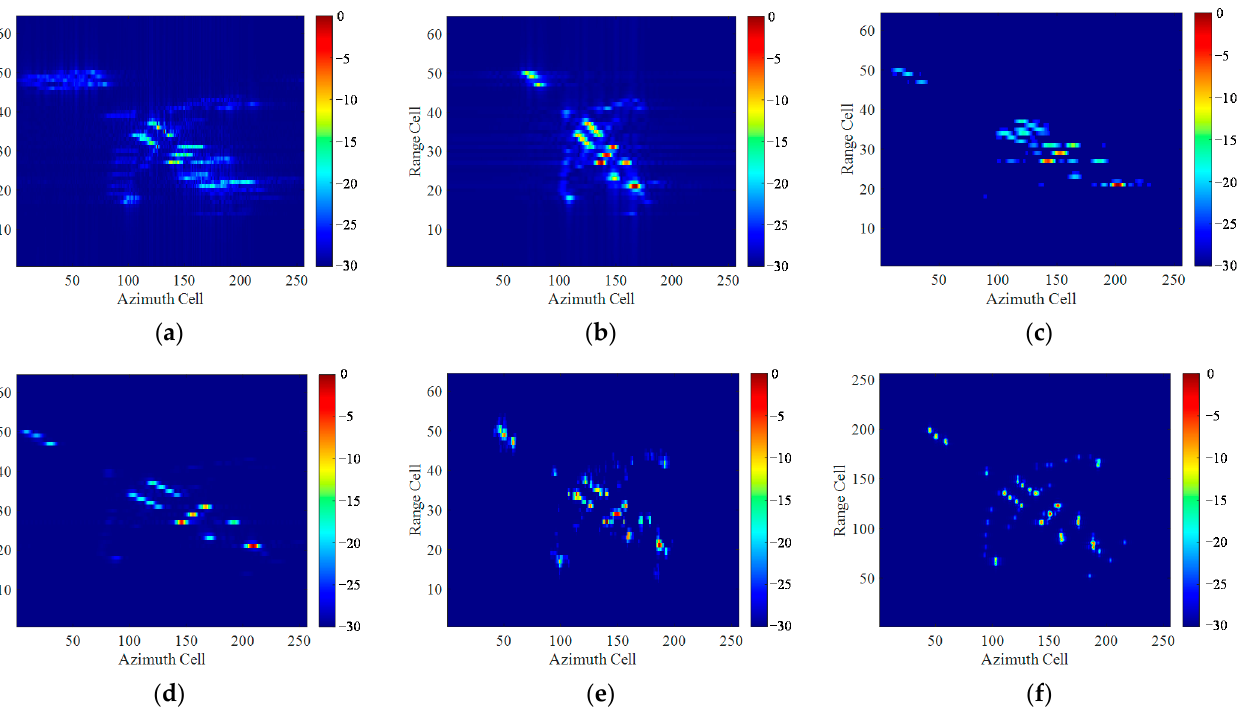
Figure 12. Imaging results of Boeing-727 data under full aperture without noise by different methods: ( a ) RD algorithm; ( b ) STFT algorithm; ( c ) WVD algorithm; ( d ) SPWVD algorithm; ( e ) RWT algorithm; ( f ) the proposed method.